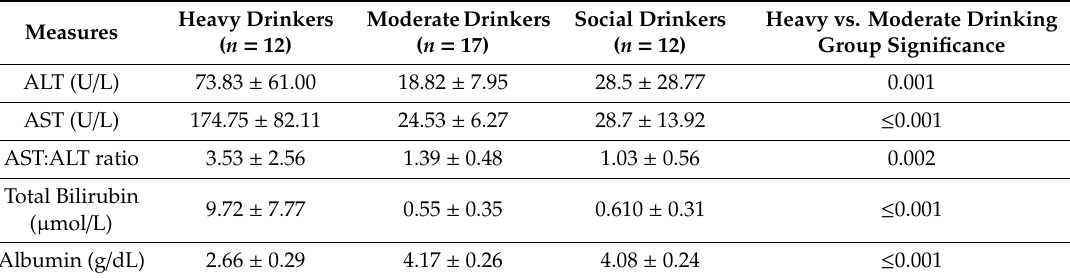
Table 3. Presentation of candidate liver panel markers.